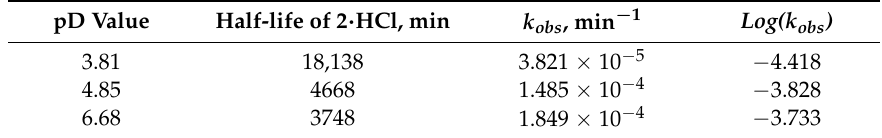
Table 1. Kinetic parameters for the hydrolysis of 2 · HCl in acidic D 2 O buffers at different pD values, 23 ◦